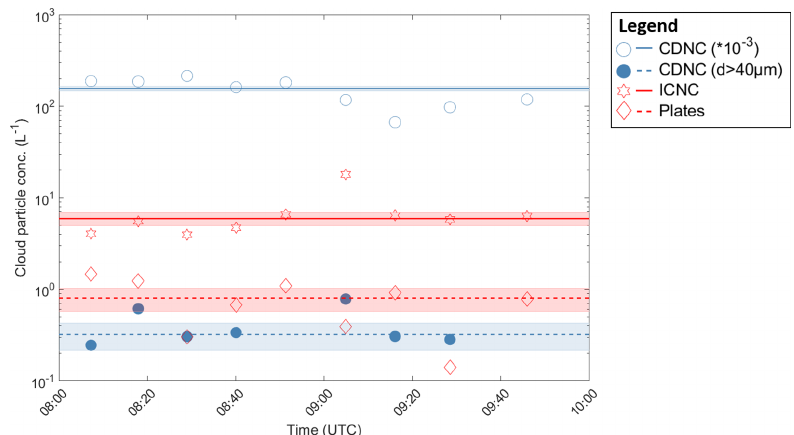
Figure 6. The ICNC, CDNC, CDNC for droplets larger than 40µm, and the concentration of plates averaged over each of the nine measure- ment rides are shown with the four different symbols. The corresponding lines show the mean concentration of the complete measurement volume with the shaded areas as the uncertainty in the mean